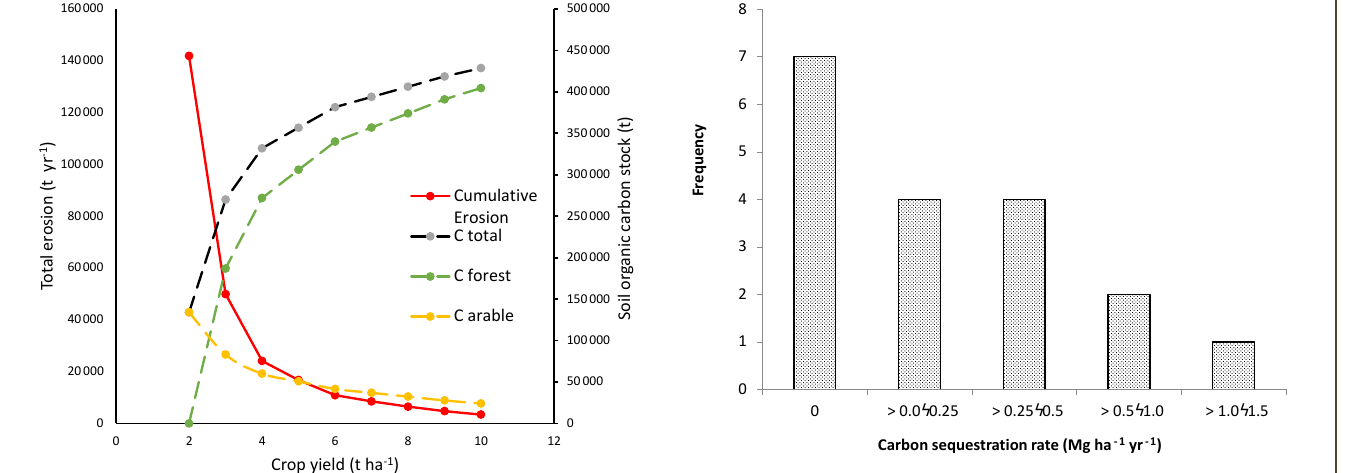
Figure 3. Modelled total erosion (tyr − 1 left axis) and soil organic carbon stocks (t, right axis) vs. crop yield per hectare for a hypo- thetical test area of 2900 ha and assuming a total cereal produc- tion of 5000t. We assumed that slope gradients (sin θ ) were uni- formly distributed between 0.02 and 0.58, i.e. an area of 100 ha in each 0.02 slope class. The crop yield shown is the crop yield on a zero slope and relative crop yield ( P ) is assumed to vary with slope: P = 1 − ( sinθ ) 0 . 5 . Erosion ( E , tha − 1 yr − 1 ) is assumed to vary with slope gradient according to the slope function derived by Nearing (1997): E ∼− 1.5 + 17/[1 + exp(2.3–6.1 sin θ )], and an erosion rate of 10tha − 1 yr − 1 is assumed on a 0.09 slope. Soil or- ganic carbon stocks per unit area are assumed to be 40 on arable land and 170tha − 1 under forest (Poeplau et al., 2011). The total soil organic carbon stock (C total) in the area strongly increases with increasing crop yield because the gain in soil organic carbon stocks on forested land (C forest) is much more important than the loss on arable land (C arable).